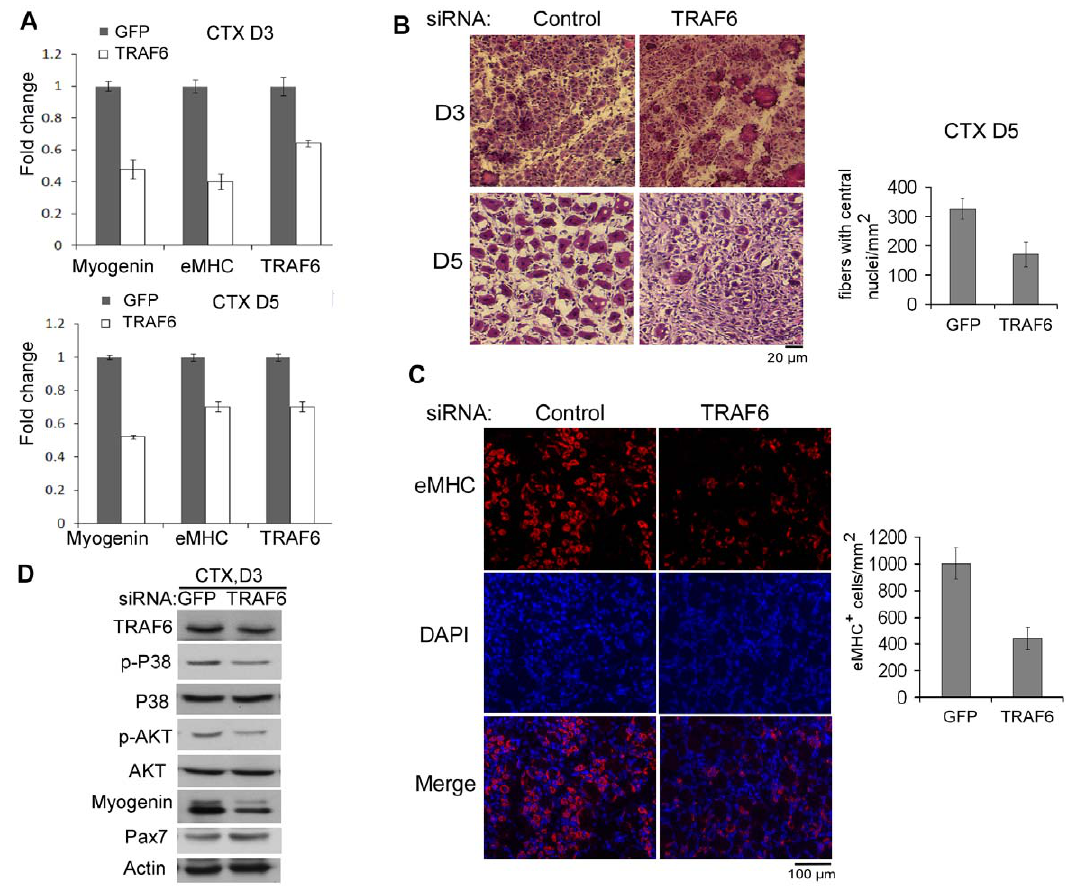
Figure 6. Knockdown of TRAF6 impaired the CTX-induced muscle regeneration. (A–D) Tibialis anterior (TA) muscles of adult mice were injected with 30 m l of 10 m M CTX. One day after CTX injection, the GFP-siRNA and TRAF6-siRNA mixed with liposome were injected into the left and right injured TA muscles respectively once per day. TA muscles were collected at day (D) 3 and day 5 after CTX injection. The total RNA, muscle sections, or WCEs were prepared and subjected to RT-qPCR (A), hematoxylin-eosin staining (B), immunostaining (C), or SDS-PAGE and Western blot analysis (D). The number of myofibers with central nuclei (B) or the number of eMHC-positive myofibers (C) was calculated from five different microscopic fields. The results were presented as mean + s.d. CTX: cardiotoxin. eMHC: embryonic MHC.